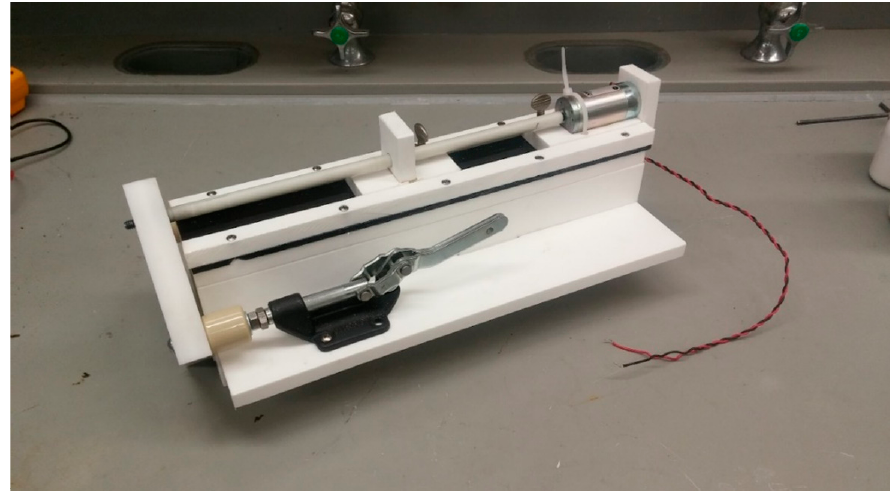
Figure A3. Photograph of the right bearing panel, toggle clamps, stabilizing bearing, and collector drive assembly. The assembly is upside down (rotated 180 degrees along its axis) from how it is installed on the device. Refer to Figure 4 for labels.